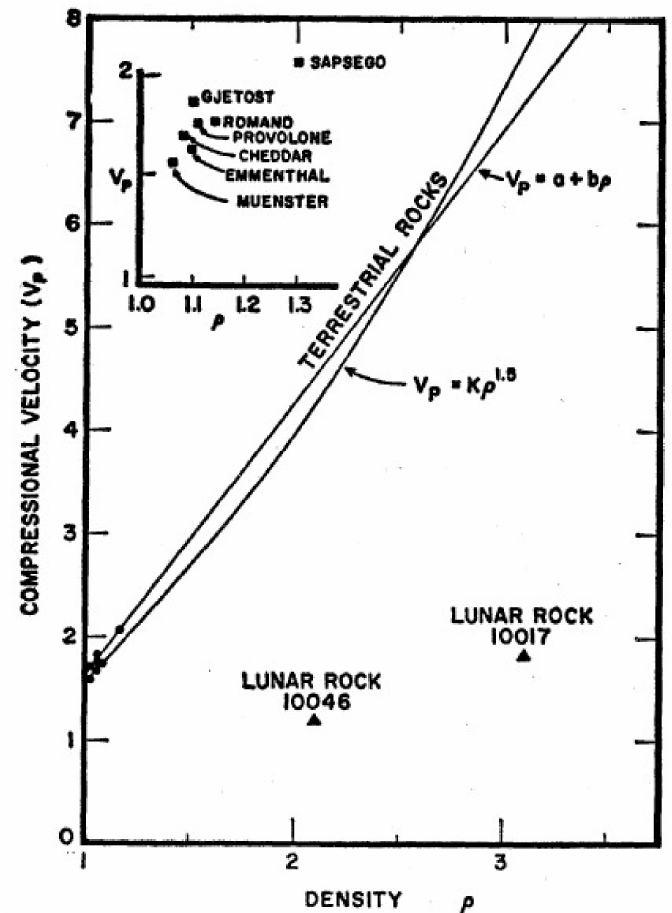
Figure 5. From Schreiber and Anderson [26] showing the comparison between sound velocities for the lunar rocks and for various earth